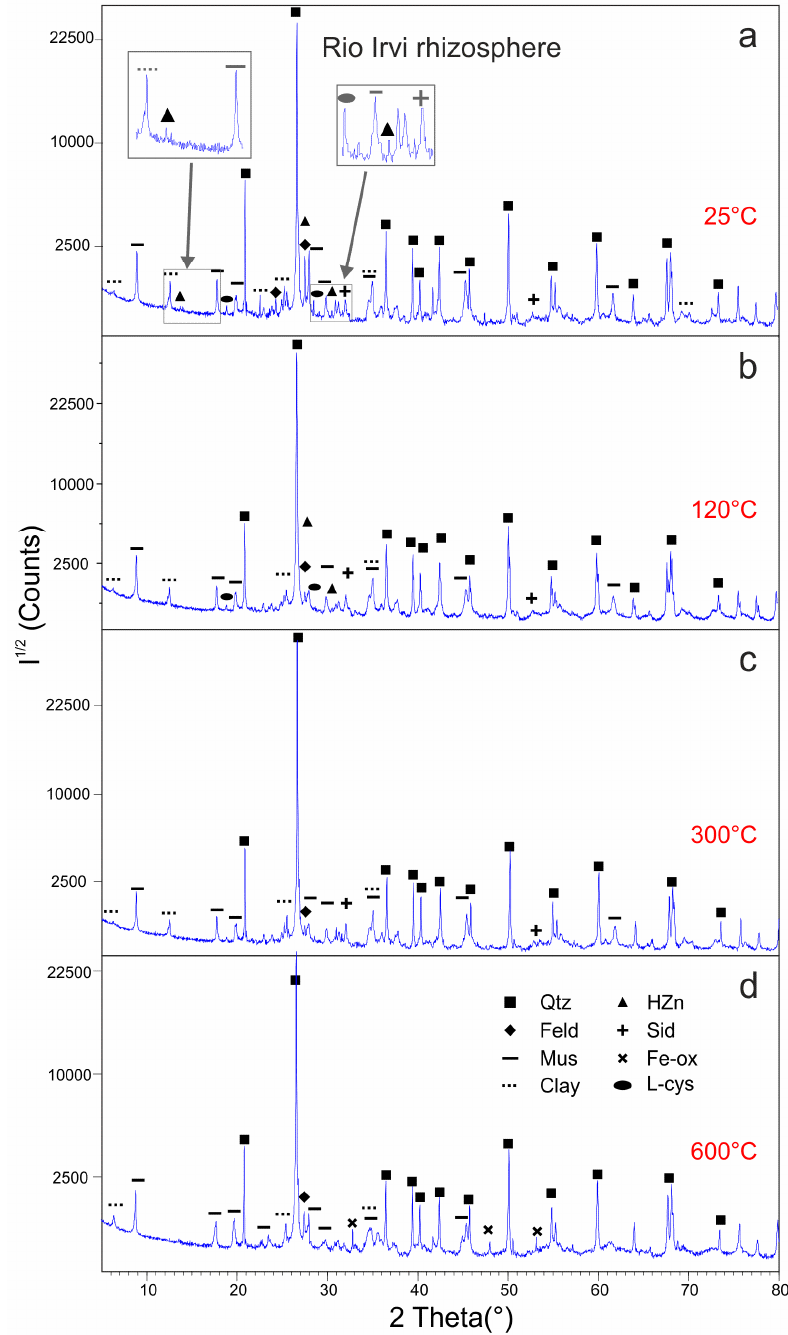
Figure 4. Comparison of X-ray Diffraction (XRD) patterns collected on rhizosphere from Rio Irvi before ( a ) and after ex-situ heating ( b–d ). Grey boxes in ( a ) show a close-up of the main hydrozincite peaks. Intensities (I 1/2 ) are reported in square root scale. Abbreviations as in Tables 2 and 3. Heating at 120 °C slightly modifies the intensity of several peaks of different phases, especially those of hydrozincite, producing the disappearance of the peak at 13.3° 2 θ and the decrease of the peak at 30.4° 2 θ (see zoom boxes in Figure 4a and Figure 4b). At 300 °C (Figure 4c), the L-cysteine and hydrozincite are completely degraded (no XRD features detected) while the other phases are